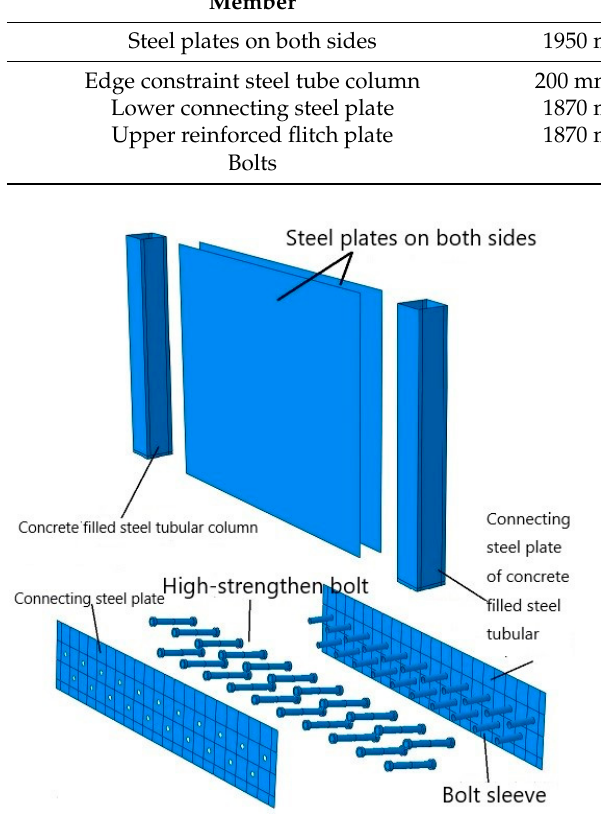
Figure 3. Description of components of upper shear wall unit.